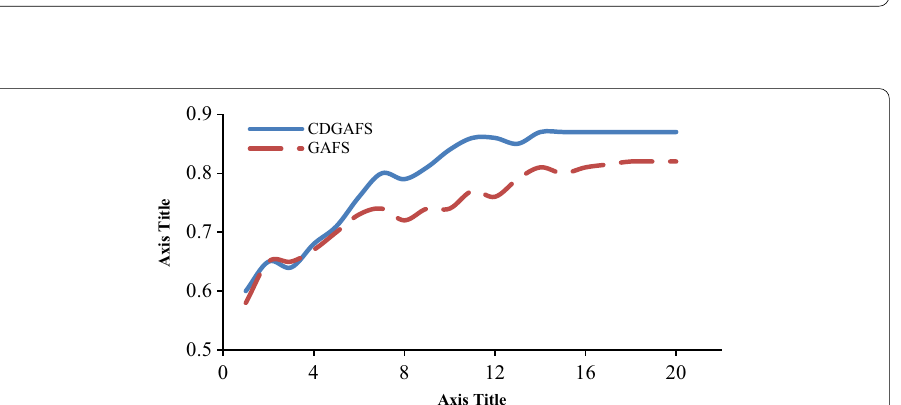
Fig. 8 Comparison of Convergence Process of Proposed Method Using Repair Operator. (CDGAFS) and Without Using Repair Operator (GAFS) on Sonar dataset